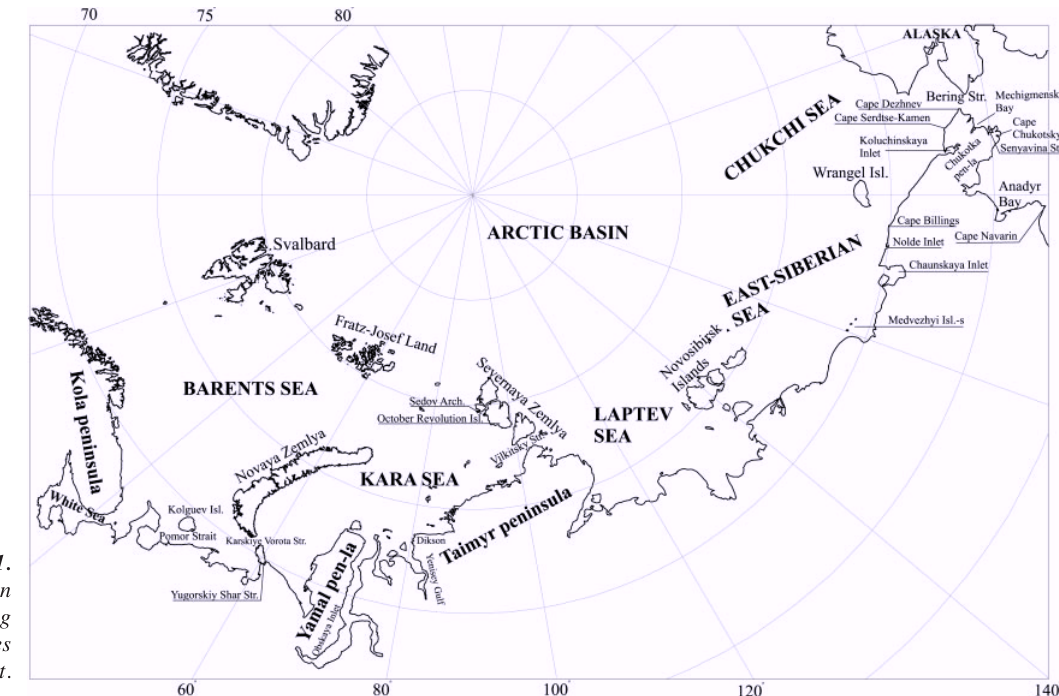
Fig. 1. The Russian Arctic, showing place names used in the